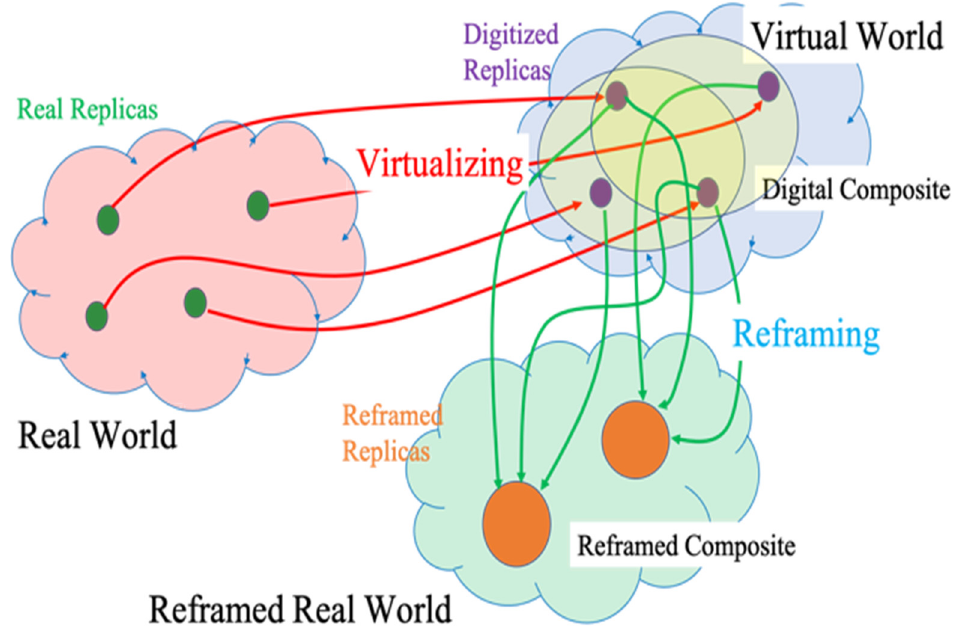
Figure 6. In Situ Figure 6. In Situ Programmable-Composite.